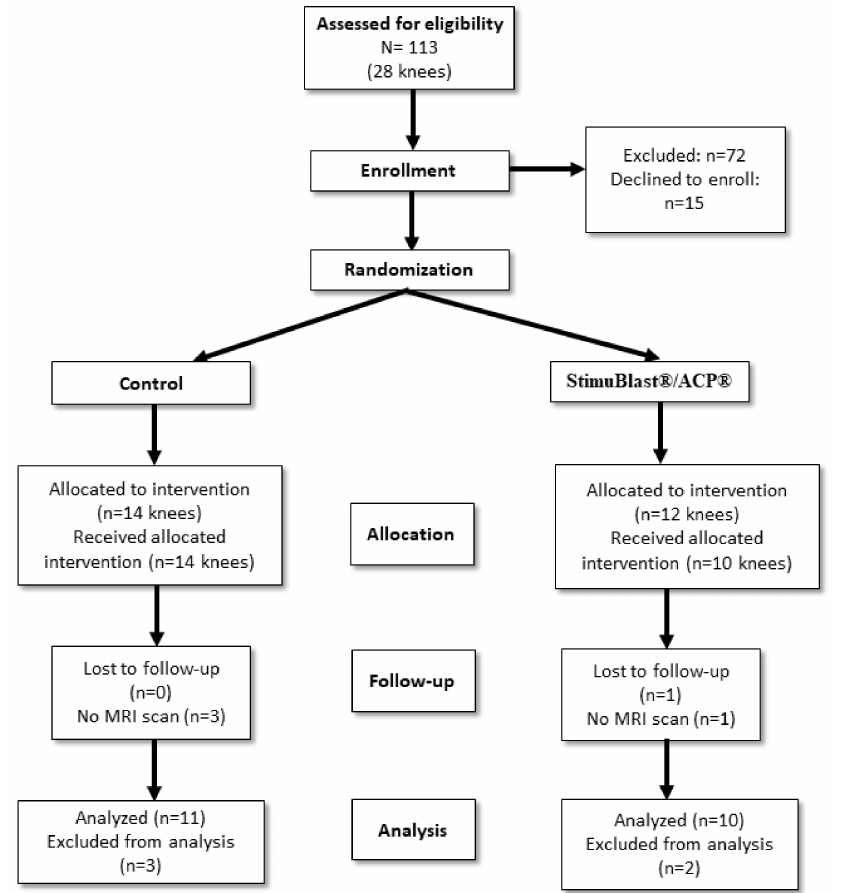
Figure 1. The chart shows the Consolidated Standards of Reporting Trials flow diagram for this randomized controlled trial with intention to treat